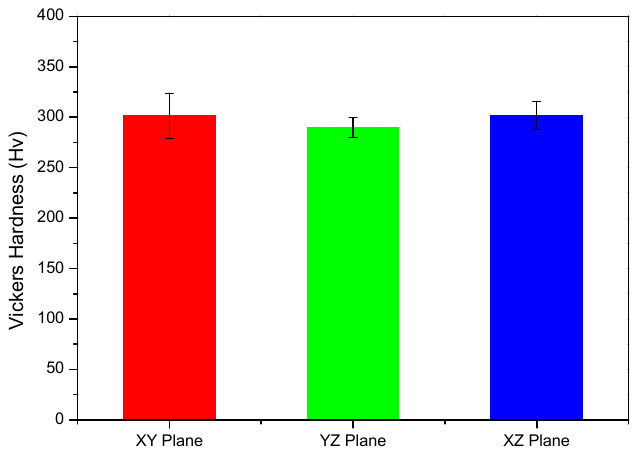
Figure 3. Average Vickers hardness of the as ‐ received Ti ‐ 6Al ‐ 4V alloy.